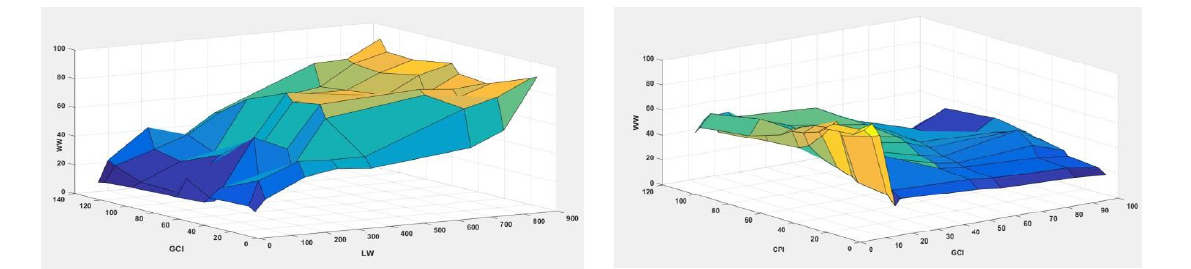
Fig. 12: Graphic representation of two-dimensional dependencies WI (GPI, CPI) Fig. 13: Graphic representation of two-dimensional dependencies WI (GCI, LW)